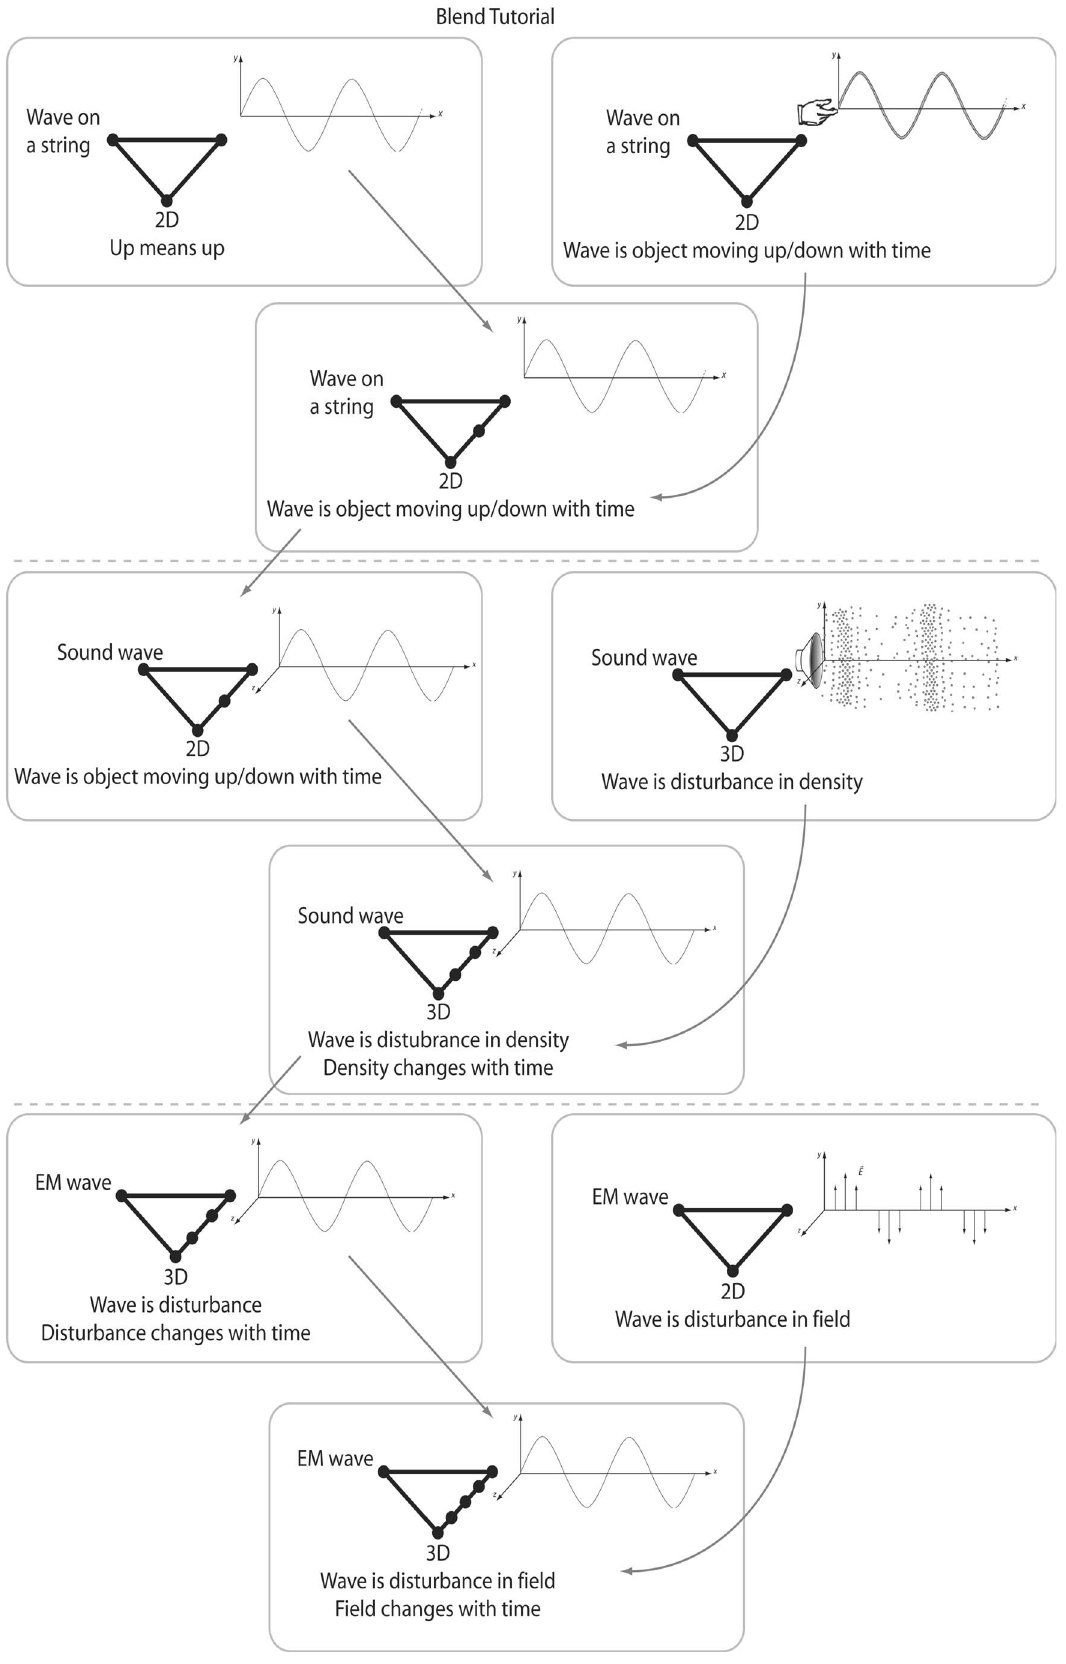
FIG. 5. Analogical scaffolding schematic for the blend tutorial. Dashed lines delineate string, sound, and EM wave